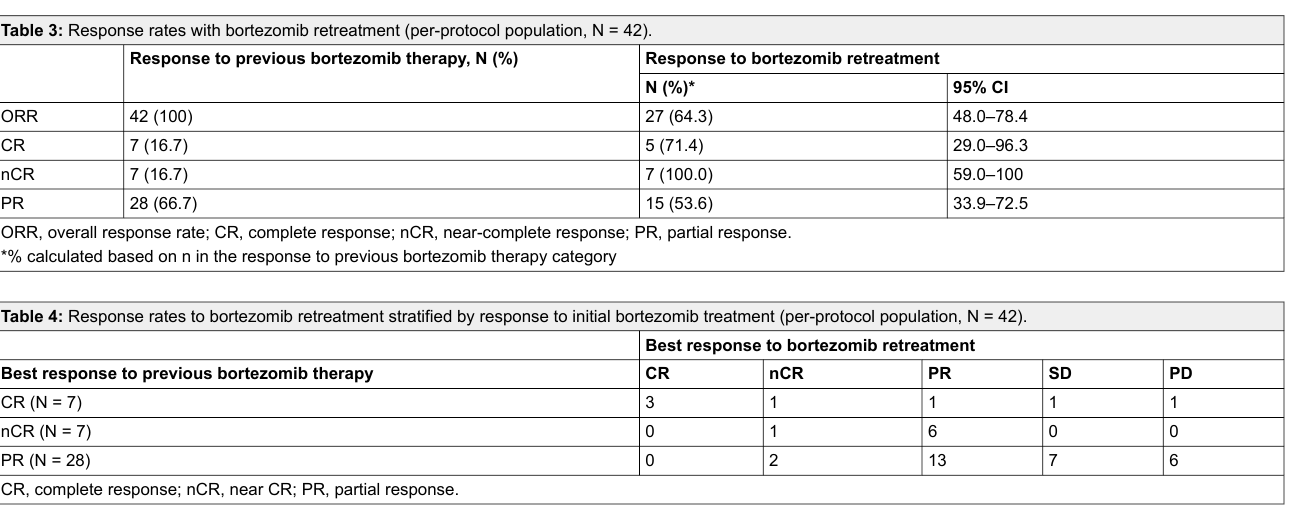
Table 3: Response rates with bortezomib retreatment (per-protocol population, N = 42).